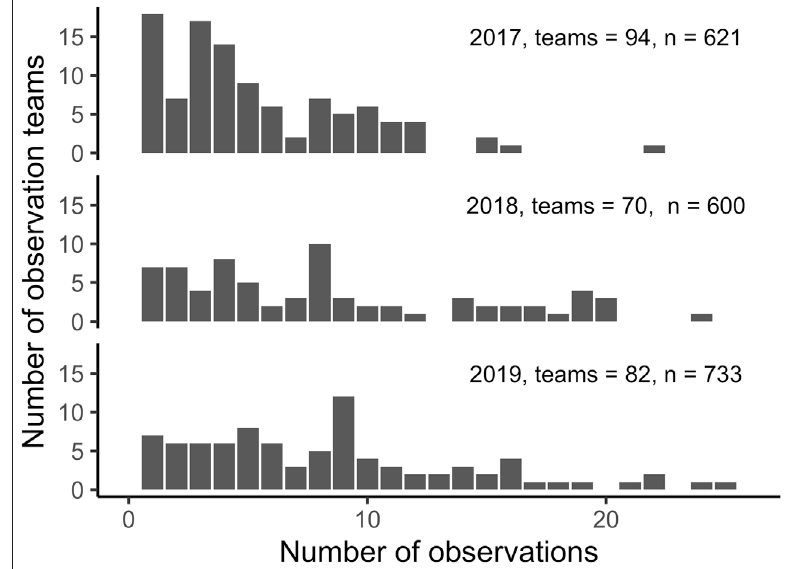
Figure 1 The number of observations varied considerably among teams, from one or two observations to more than 20. (One team, not shown in the figure, collected 33 observations in 2017).